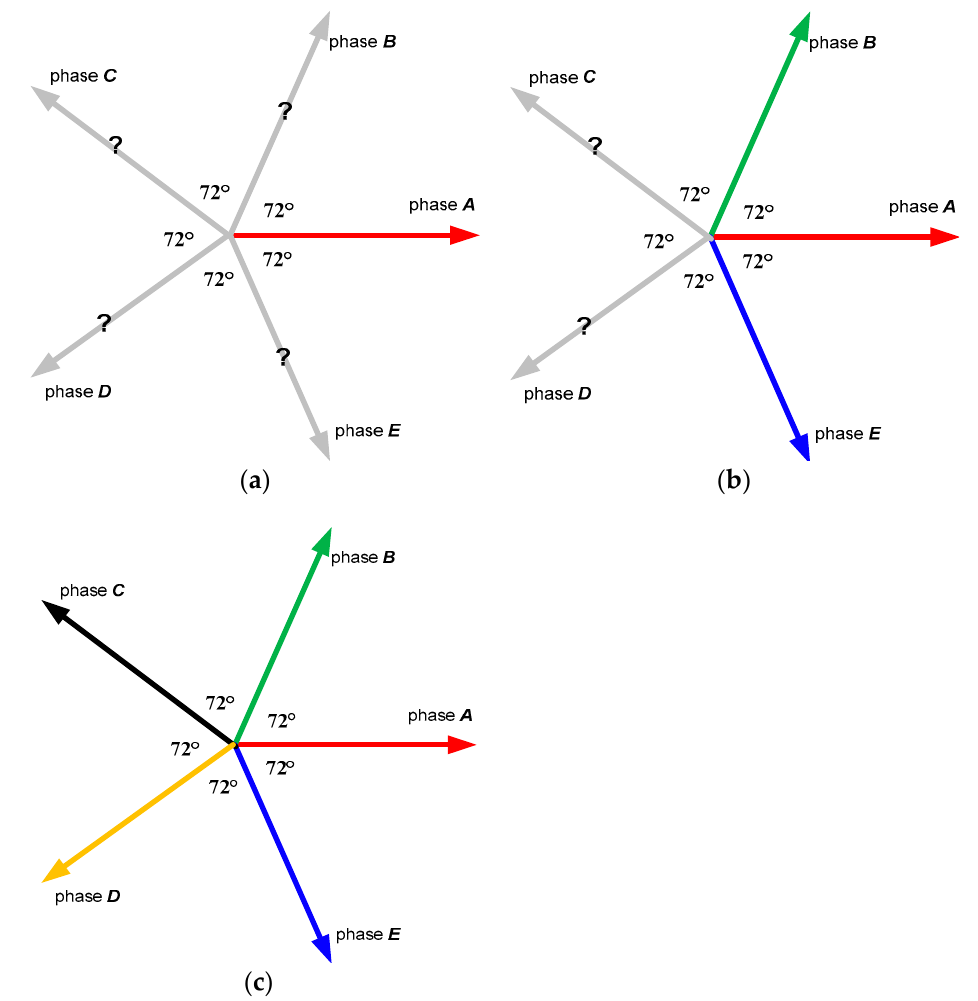
Figure 9. Steps of phases sequence identification represented in star of slot phasors, ( a ) phasors of